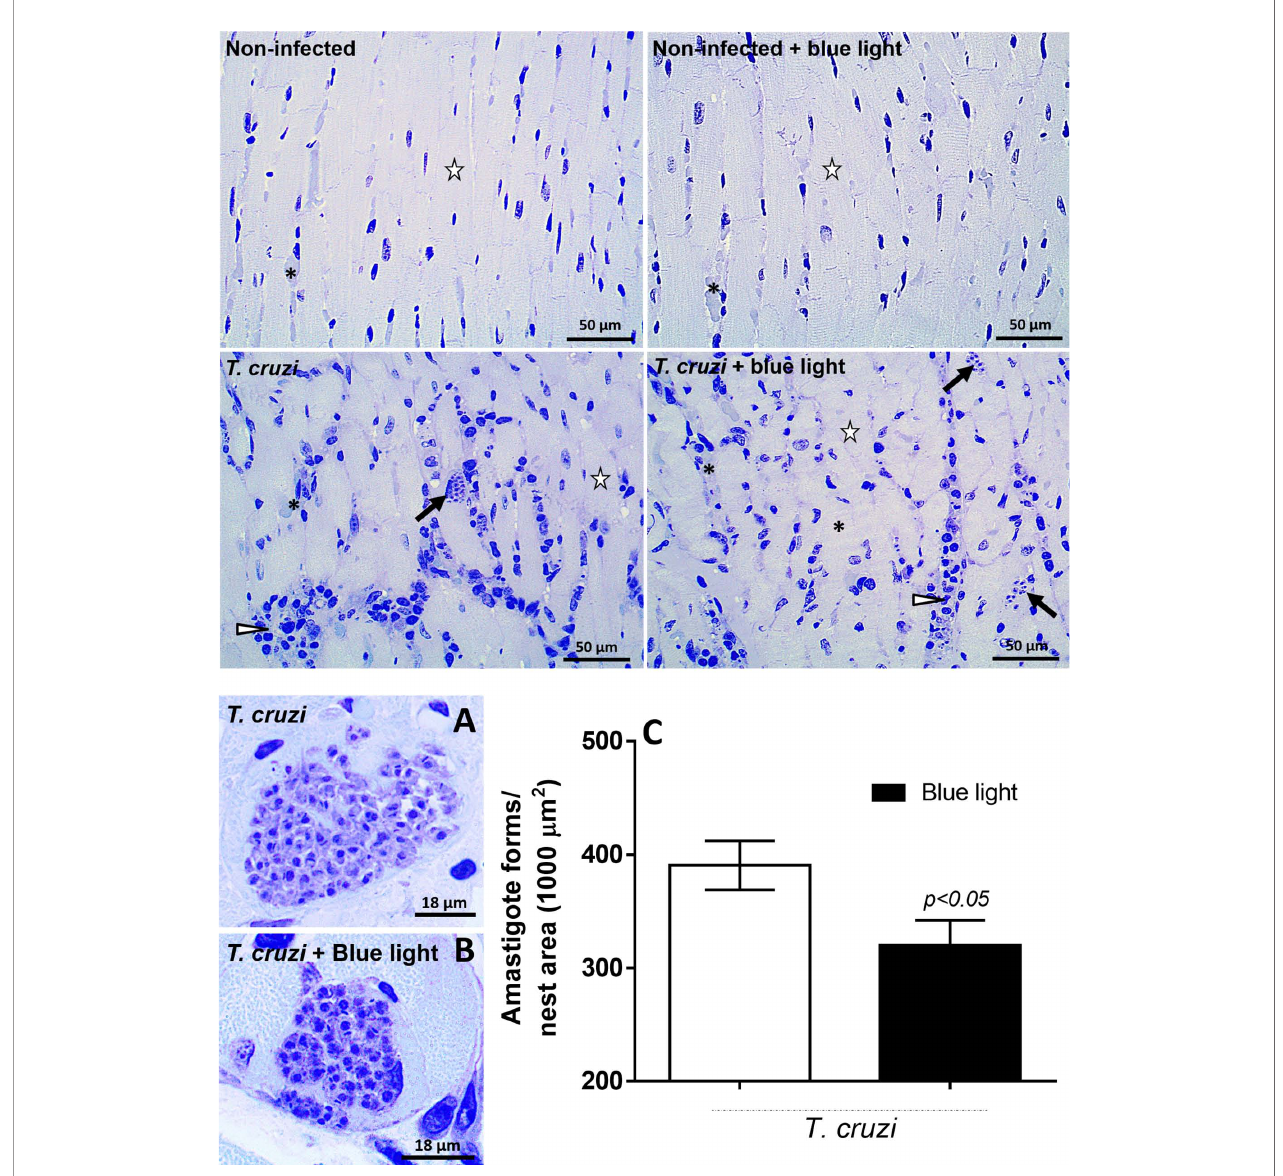
FIGURE 6 | Quanti fi cation of amastigote nests in cardiac tissue. The amastigote nests of the T. cruzi were evidenced in the upper images with reduction of visual parasites in the infected group under blue light therapy. (A) An amastigote nest from animals under conventional light therapy, (B) an amastigote nest from animals under blue light therapy and (C) quanti fi cation of the area of the amastigote nests. p<0.05 means differences between infected groups under conventional and blue light therapy. Arrow – the T. cruzi amastigote nest, arrowhead – the in fl ammatory foci, asterisk – the blood